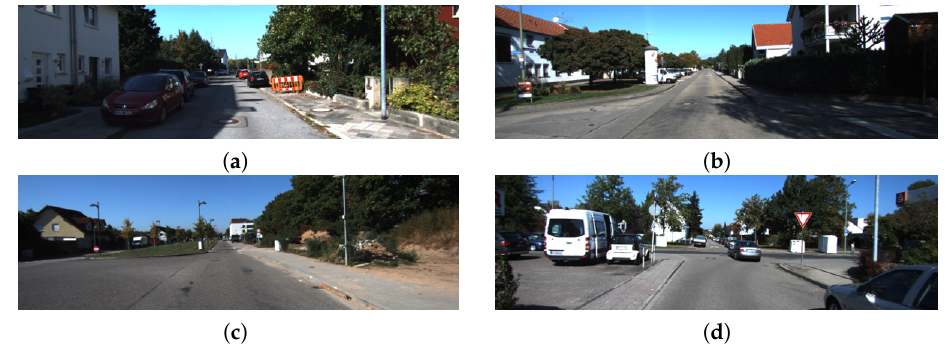
Figure 6. Typical scenes from KITTI sequences. ( a ) sequence 00; ( b ) sequence 05; ( c ) sequence 06; and ( d ) sequence 08. These scenes are dominated by unstructured objects, which can easily cause mismatches.